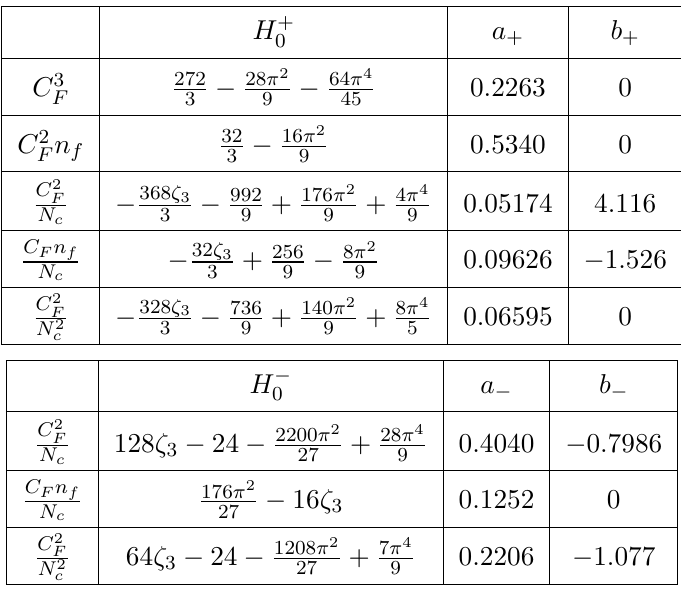
( x ) (5.21) , (5.22) inv